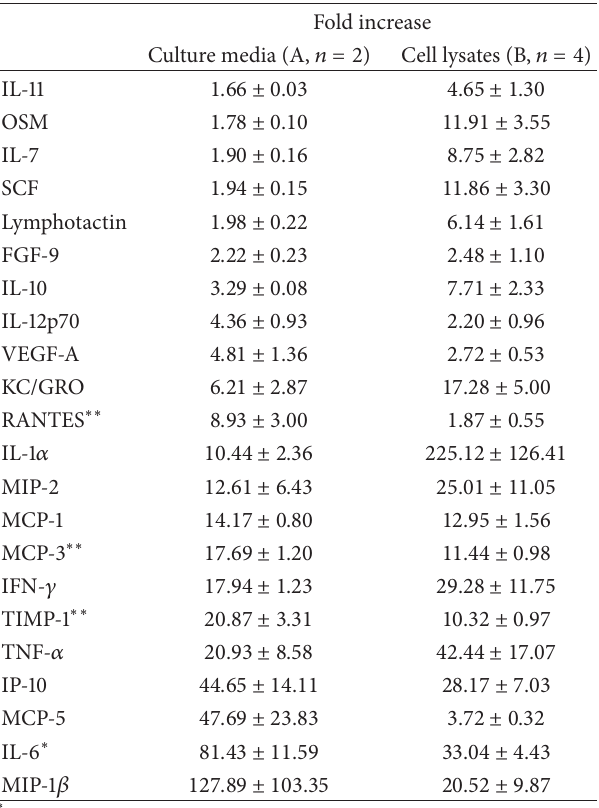
Table 3: Fold increases of inflammatory mediator productions in cell culture media and lysates of murine peritoneal macrophages following LPS treatment for 24h in